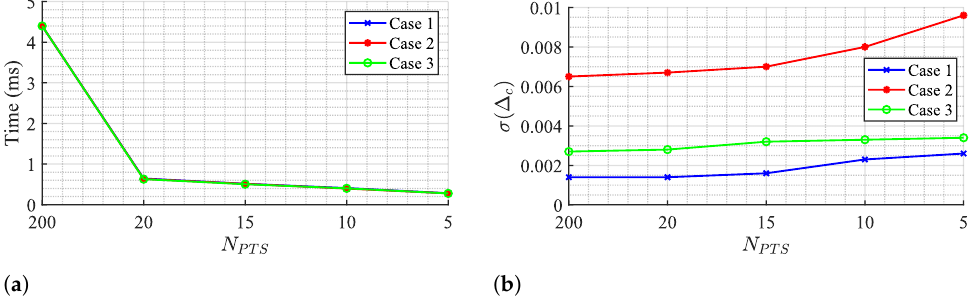
Figure 16. OC algorithm performance for few C k points: ( a ) Run time, ( b ) Estimation variability σ ( ∆ C )